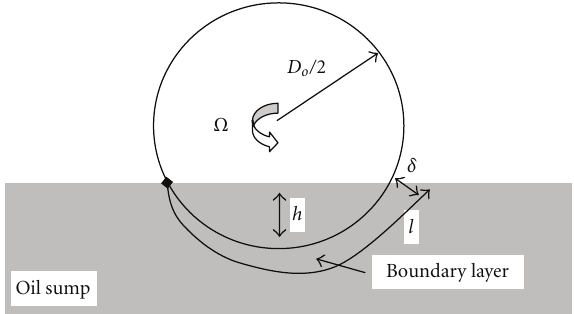
Figure 8: Schematic representation of the boundary layer on the side of a rotating